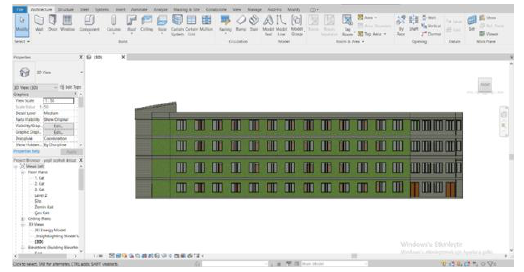
Figure 17 Faculty of Economics and Administrative Sciences Block A Building North Facade View with Vertical Green System